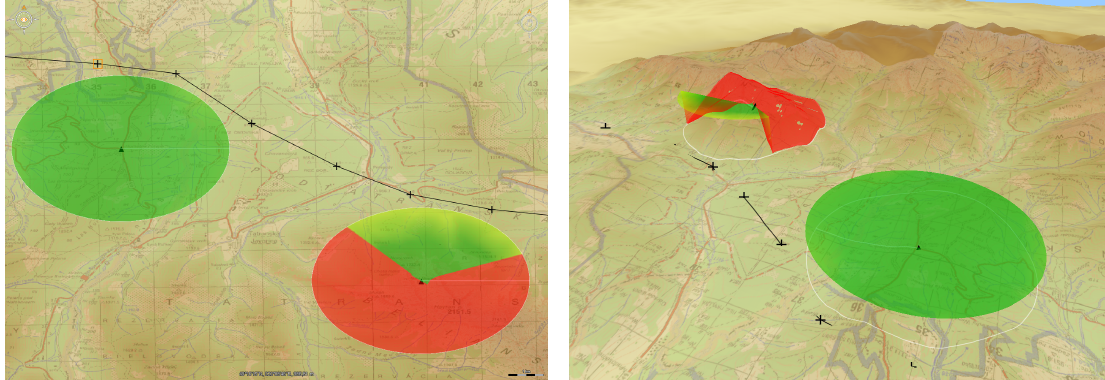
Figure 7. Routing plan for UAV with SAR sensors. Two reconnaissance tasks are presented.